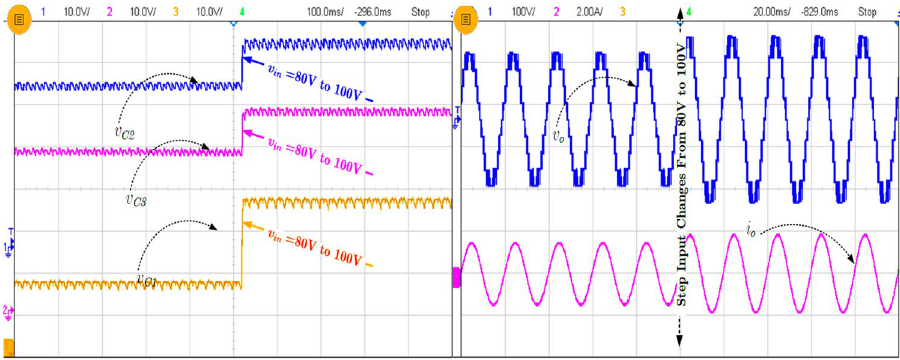
Figure 9. Experimental result of step input change from 80 to 100 V.